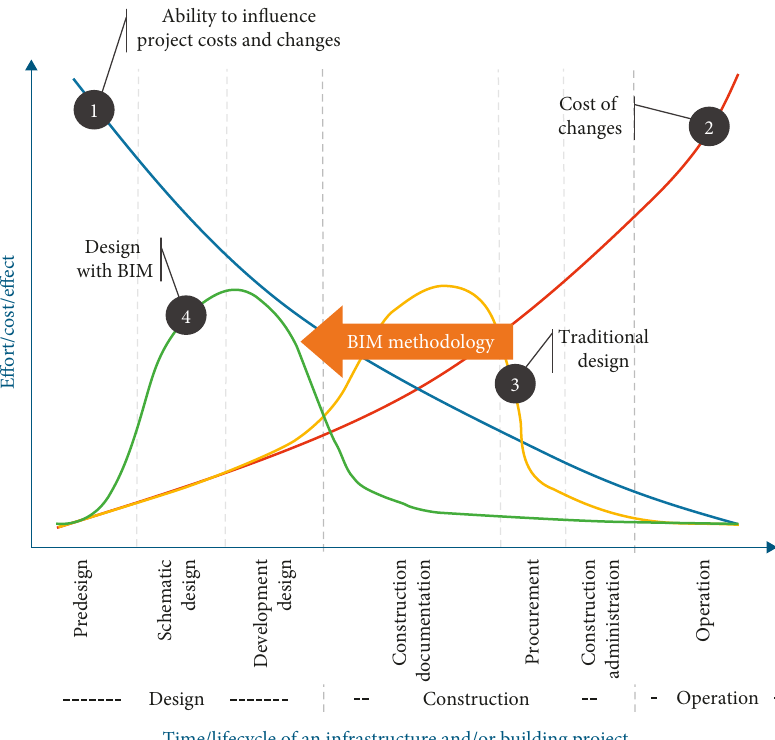
Figure 1: MacLeamy time-effort distribution curves in construction